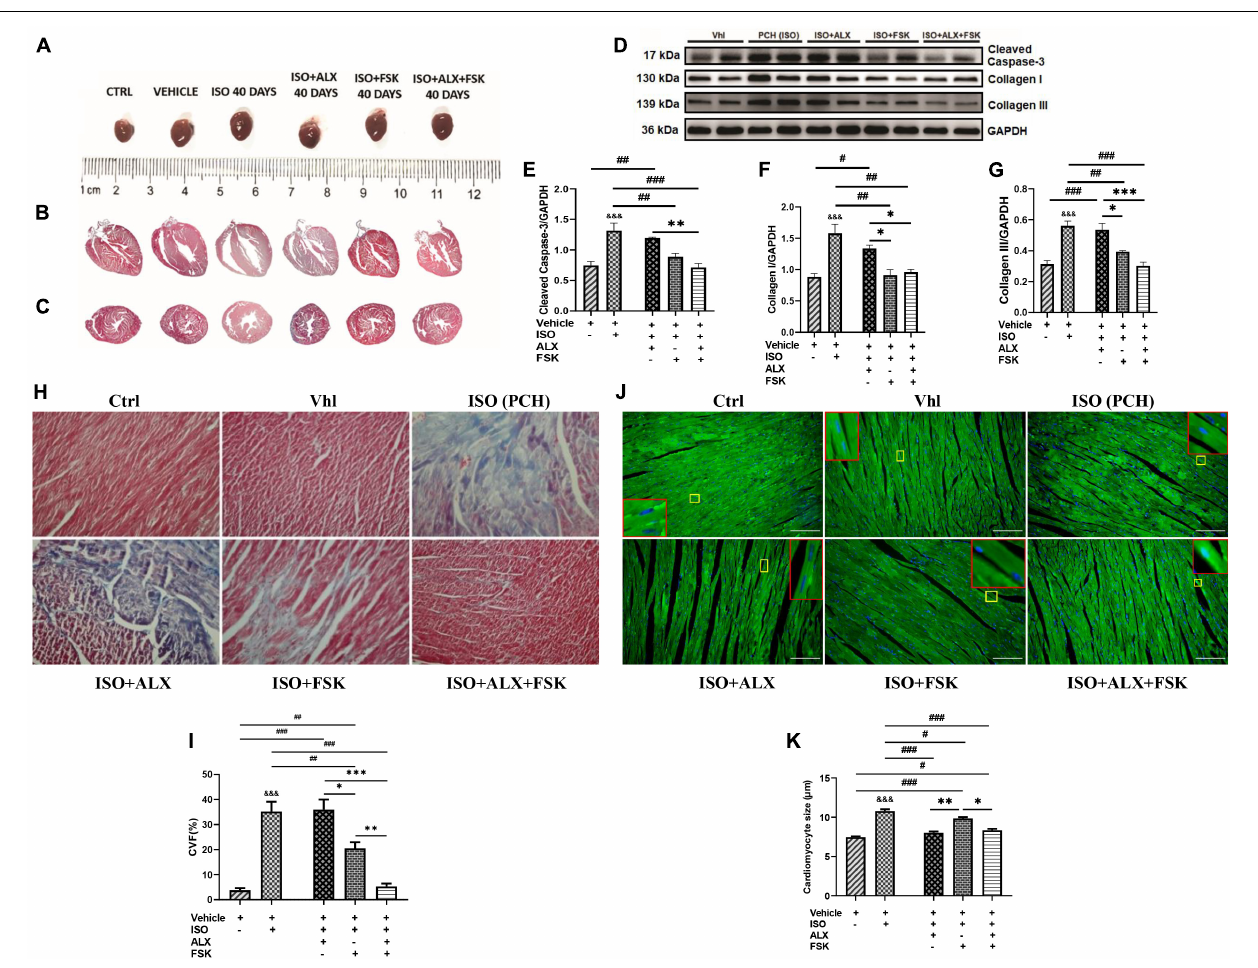
FIGURE 4 | ALX and FSK combination preserves mice myocardial architecture during CCS. (A) Representative whole hearts from all experimental groups. (B) Representative Masson’s trichrome stained longitudinal section of whole hearts from all groups. (C) Representative Masson’s trichrome stained transverse section of whole hearts from all groups. (D–G) Representative Western blots and graphical presentations cleaved caspase 3, collagen I, and collagen III compared between Vhl and PCH mice, and ALX treatment, FSK treatment, and ALX and FSK combination treatment ( n = 4 hearts per treatment group). Western blots were performed in triplicates, and each protein band in the representative blot is an independent biological sample. (H,I) Representative microscopic images of Masson’s trichrome staining and collagen volume fraction (CVF) in the ventricular tissue sections from all groups. The plotted values are the means of the CVF from each mouse ( n = 6–8 fields of view per 5–7 sections per 8–16 hearts per group). (J,K) Representative microscopic images of wheat germ agglutinin (WGA) merged with DAPI staining and graphical presentation of measured cardiomyocyte diameters from ventricular tissue sectionings across all groups. The plotted values are the means of the cardiomyocyte sizes from each mouse ( n = 10–12 cells per five fields of view per five sections per six to seven hearts per group). Representative cardiomyocytes are marked in yellow boxes, and their zoomed-in ( × 5) inserts to show hypertrophy are marked in red boxes. The Vhl mice group is representative of the Ctrl mice group in results illustrations due to similarity in their data. ∗ p < 0.05, ∗∗ p < 0.01, ∗∗∗ p < 0.001 among the therapeutic groups; &&& p < 0.001 vs. Vhl; # p < 0.05, ## p < 0.01, ### p < 0.001 vs. the therapeutic groups. CVF was estimated by dividing the collagen area with the total myocardial area and multiple by 100. Data are expressed as mean ± SEM. Data were analyzed using one-way ANOVA, followed by Tukey’s post hoc